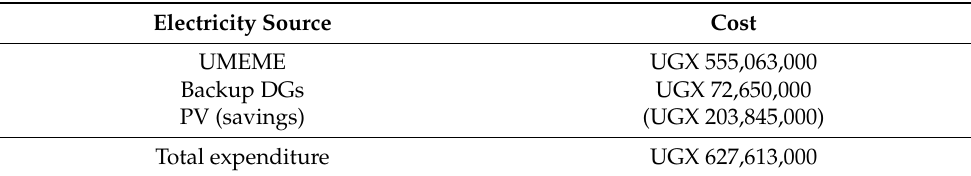
Table 1. Electricity costs of the hospital for financial year 2021/22.